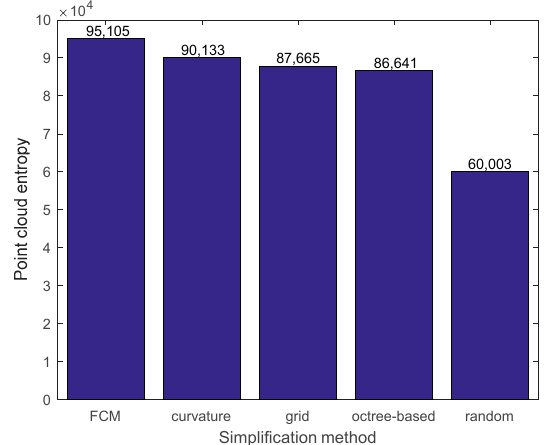
Figure 7. Entropy under different simplified algorithms.